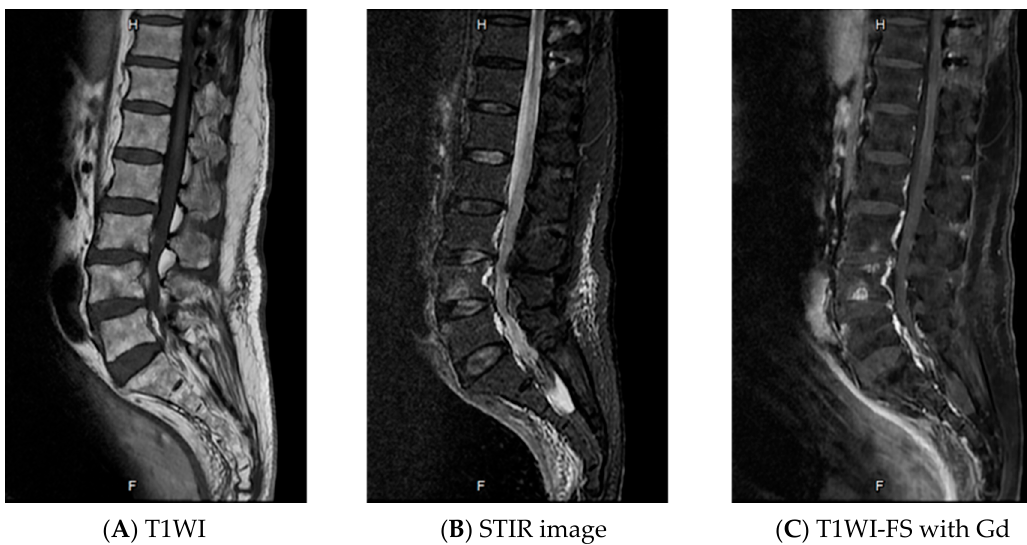
Figure 2. Magnetic resonance imaging of the lumbosacral spine at the 16th month of treatment showing complete resolution of the lesion.